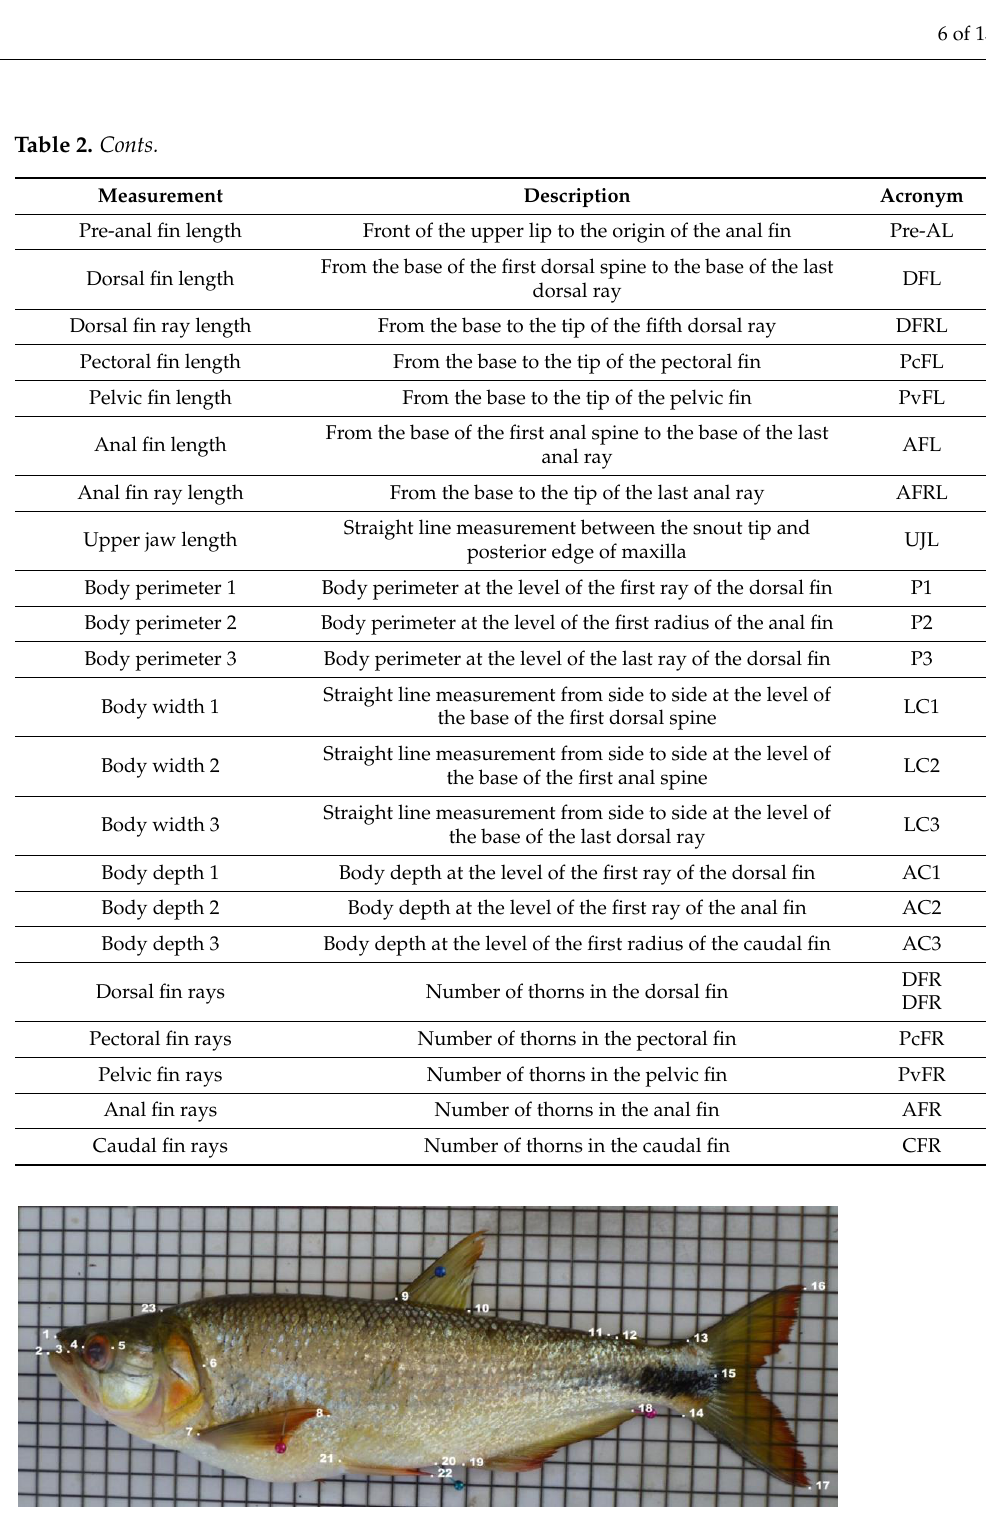
Figure 2. Locations of 23 anatomical landmark points showed in the left view of the Brycon dentex . Landmark points: 1: highest cranial point of the upper pre-maxilla; 2: highest cranial point of the lower pre-maxilla; 3: commissure of the mouth; 4: anterior edge of the eye; 5: posterior edge of the eye; 6: end of the operculum; 7: origin of the pectoral fin; 8: end of the pectoral fin radius; 9: origin of the first dorsal fin; 10: end of the dorsal fin; 11: origin of the second dorsal fin; 12: end of the second dorsal fin; 13: dorsal origin of the caudal fin; 14: ventral origin of the caudal fin; 15: highest cranial point of the caudal peduncle; 16: highest caudal point in the superior part of the caudal peduncle; 17: highest caudal point in the inferior part of the caudal peduncle; 18: end of the anal fin; 19: origin of the anal fin; 20: anal opening; 21: origin of the pelvic fin; 22: end of the pelvic fin radius; 23: nape, highest caudal point of the head.